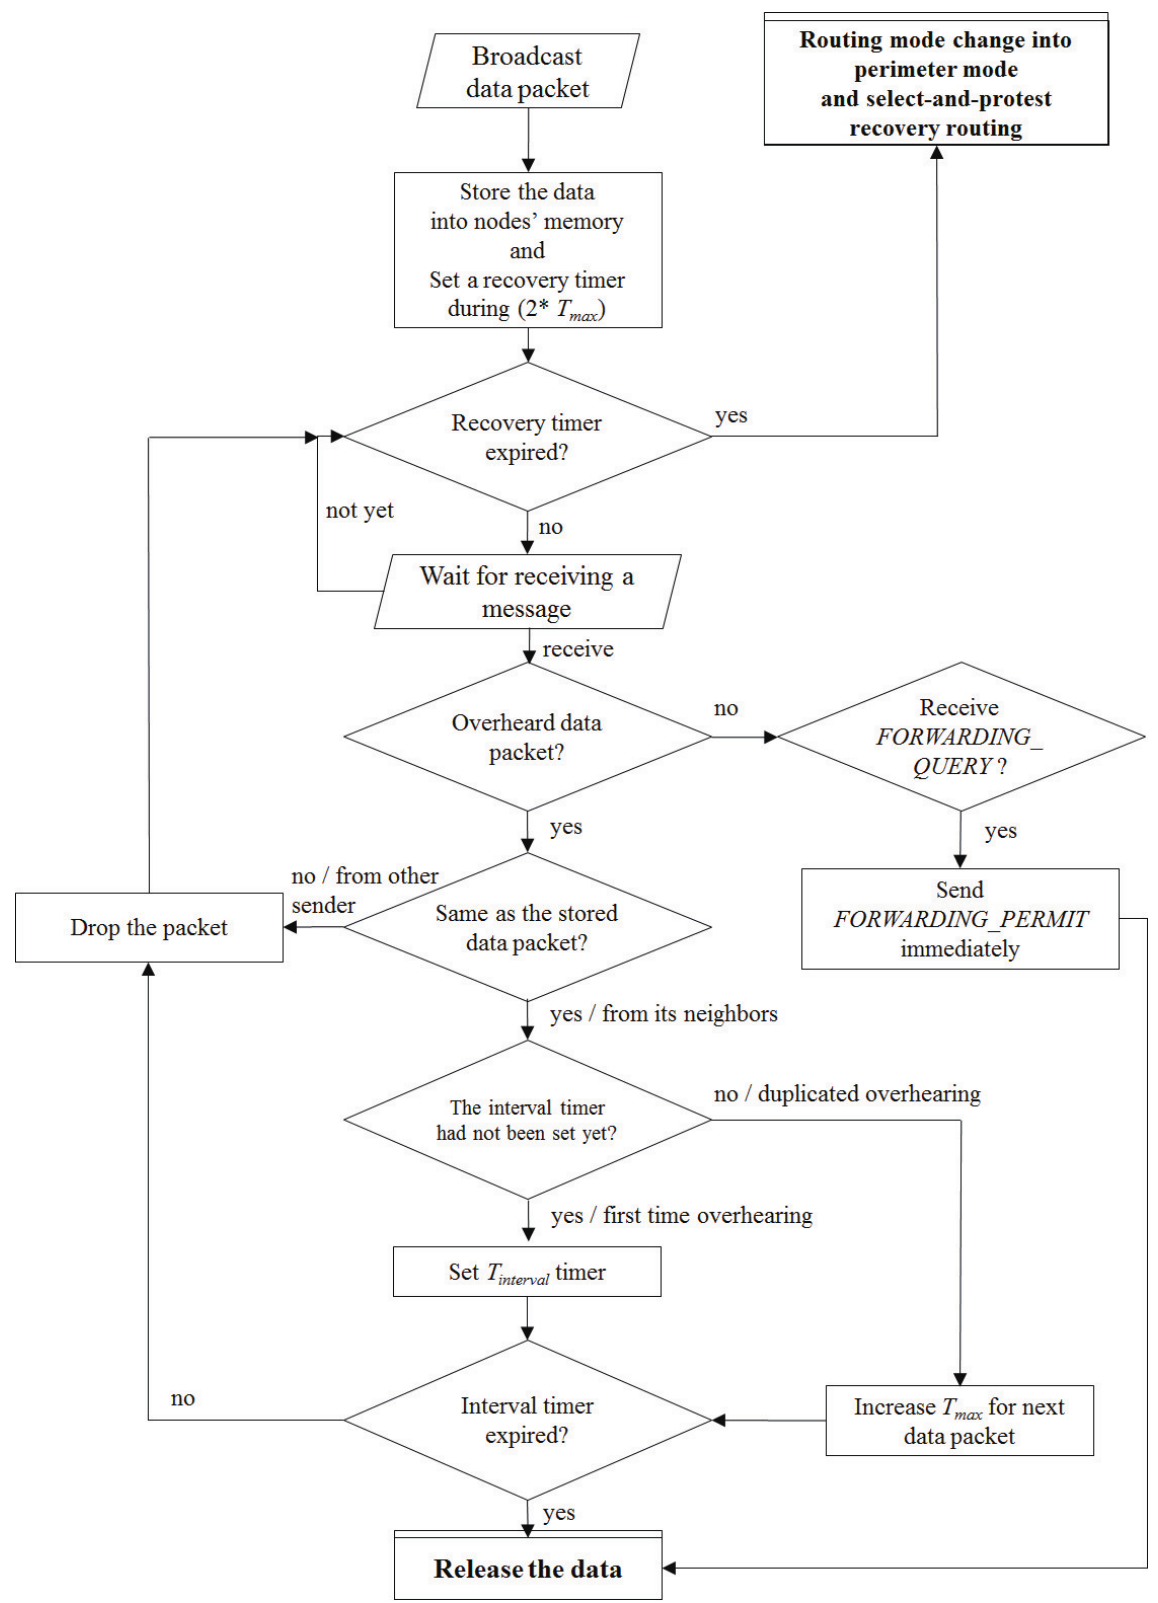
Figure 3. The flowchart of the sender